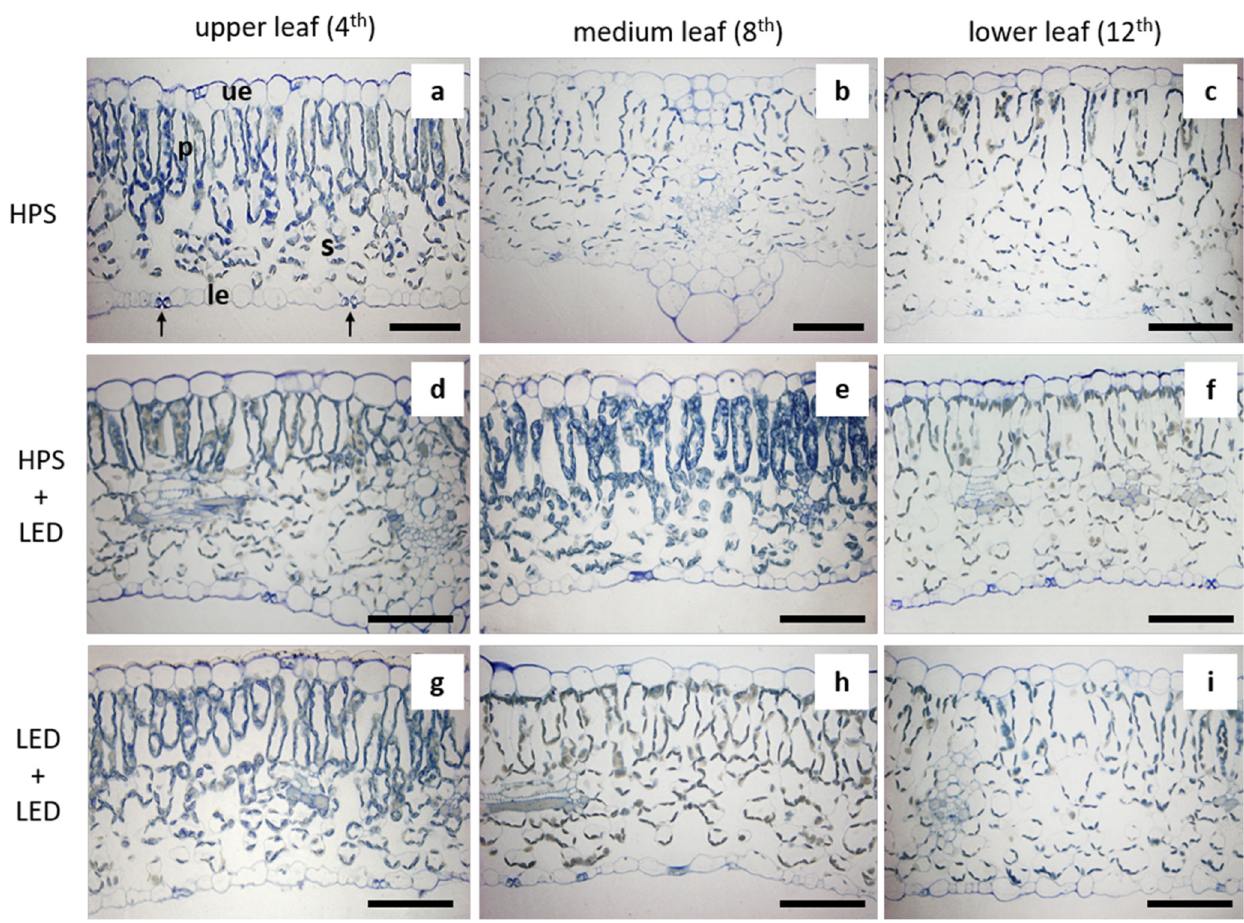
Figure 1. Light microscopy investigations: cucumber leaf anatomy under different light conditions (representative images). ( a ) HPS, upper leaf; ( b ) HPS, medium leaf; ( c ) HPS, lower leaf; ( d ) HPS + LED, upper leaf; ( e ) HPS + LED, medium leaf; ( f ) HPS + LED, lower leaf; ( g ) LED + LED, upper leaf; ( h ) LED + LED, medium leaf; ( i ) LED + LED, lower leaf. Notice that the highest affinity of leaves to methylene blue and azure A staining was found in case of the upper leaves independently of the supplemental light conditions. The affinity was also high for the medium leaves of plants grown under HPS + LED lighting. This affinity probably results from the presence of starch granules in chloroplasts (compare with Figure 2). Abbreviations: arrow—stoma; le/ue—lower/upper epidermis; HPS—high-pressure sodium lamps used as toplighting; HPS + LED—HPS toplighting and LED interlighting; LED + LED—light-emitting diode lamps used as toplighting and interlighting; p /s—palisade/spongy mesophyll tissue. Bars = 100 µm.